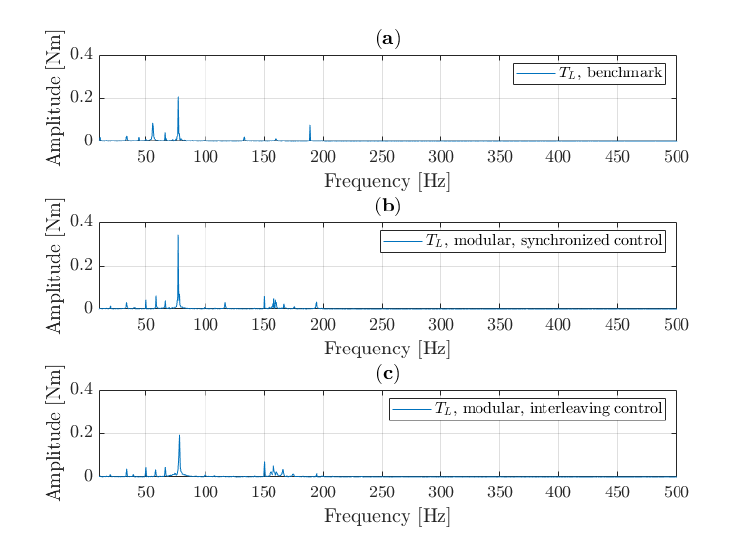
Figure 15. Measured torque ripple amplitude at 4 kHz PWM switching frequency in ( a ) the bench- mark scenario, 0.21 Nm at the resonance mode; ( b ) the synchronized control modular scenario, 0.34 Nm; ( c ) the interleaving control modular scenario, 0.19 Nm.